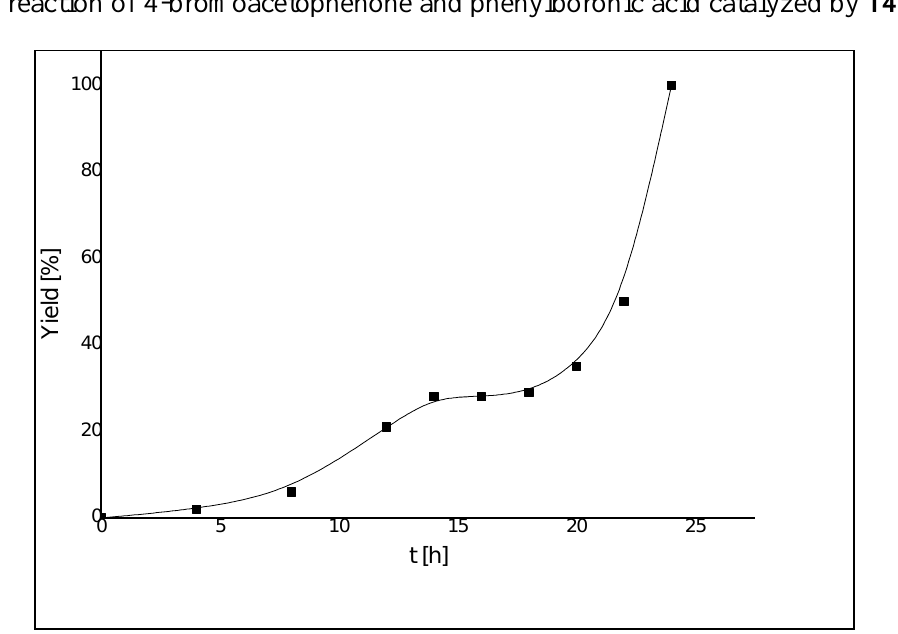
Figure 17. Concentration/time diagram [yield (%), time (h)] for the Suzuki-Miyaura coupling reaction of 4-bromoacetophenone and phenylboronic acid catalyzed by 14